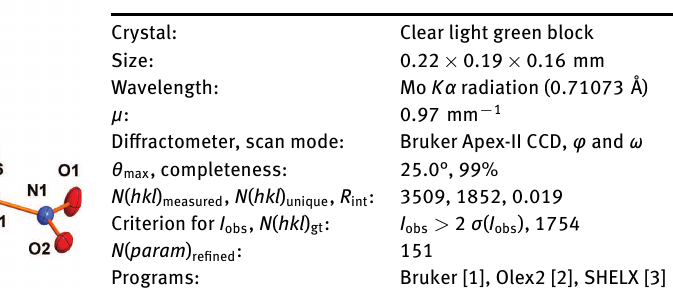
Table 1: Data collection and handling.